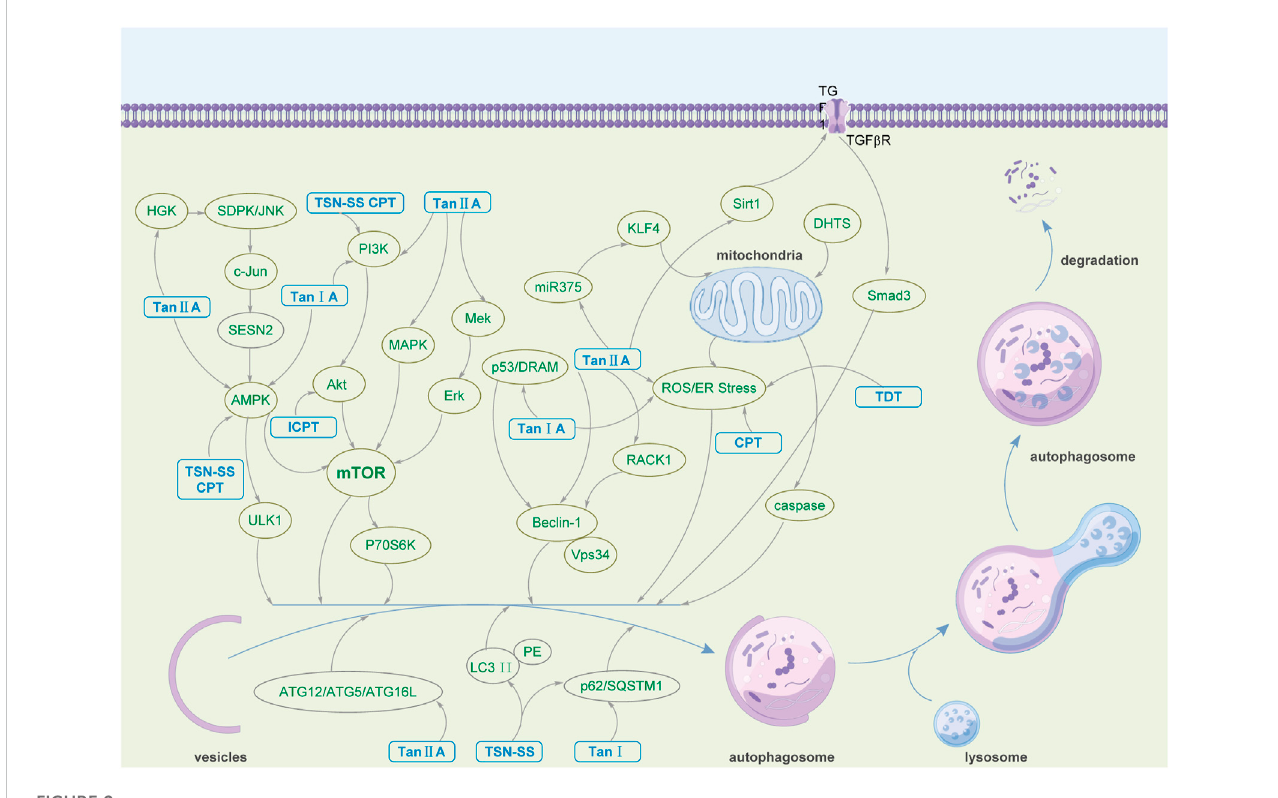
FIGURE 2 The pharmacological mechanism by which tanshinone regulates